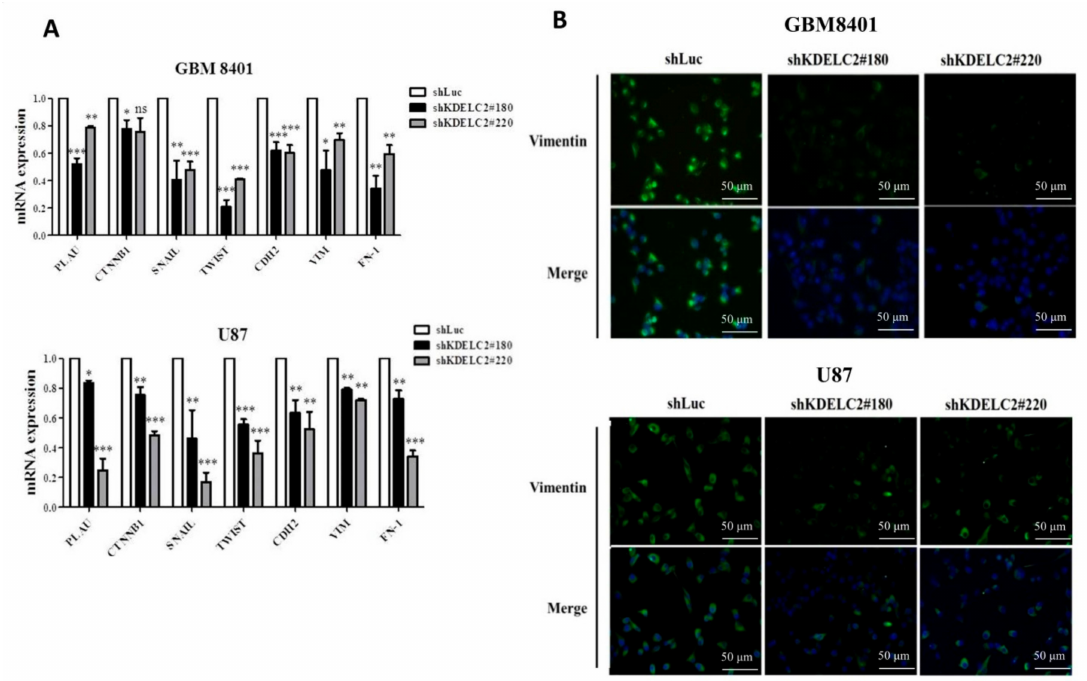
Figure 7. KDELC2 knockdown decreased epithelial–mesenchymal transition (EMT) of glioblastomas (GBMs). ( A ) Assay of qRT-PCR of GBM8401 revealed that knockdown of KDELC2 inhibited the mRNA expression of some mesenchymal factors, including PLAU, CTNNB1, Snail, Twist, CDH2, vimentin, and FN-1. Bars, means ± SEM. * p < 0.05; ** p < 0.01; *** p < 0.0001. ( B ) Immunofluorescence staining indicated that knockdown of KDELC2 decreased vimentin expression of GBM8401 and U87